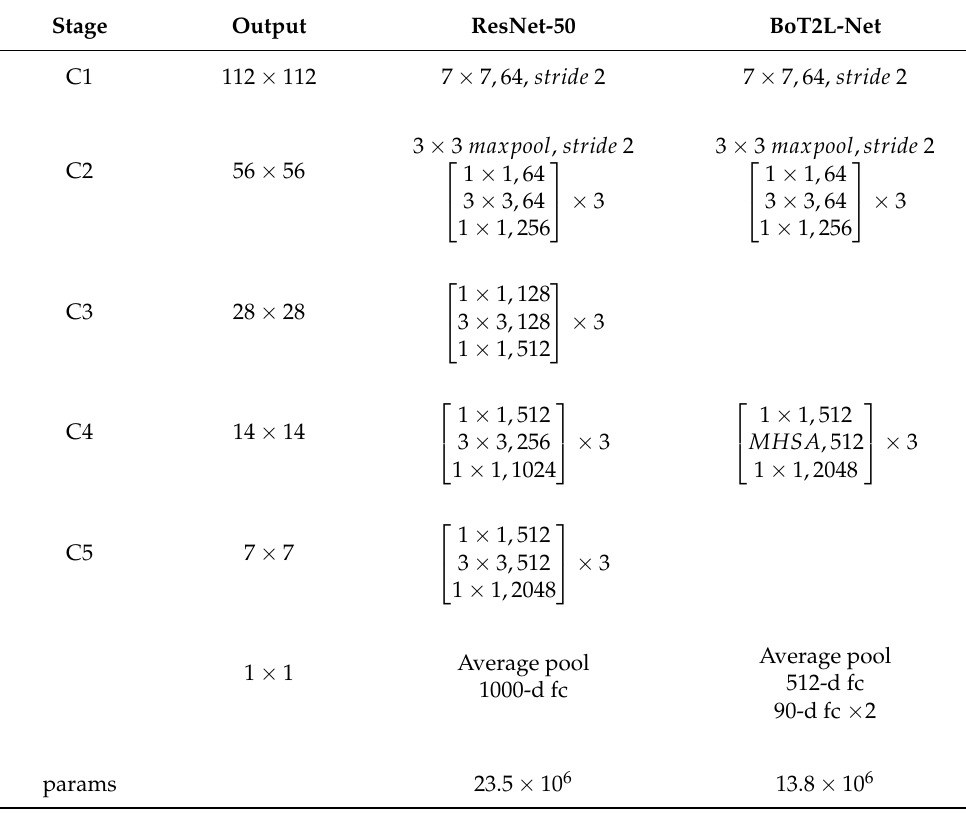
Table 1. Comparison of BoT2L-Net and ResNet-50 network structures and